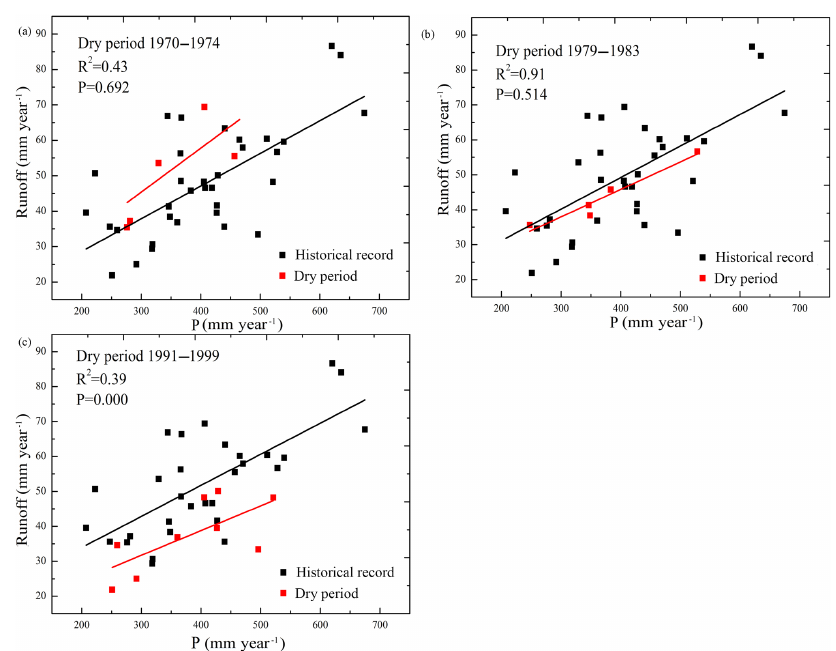
Figure 3. Precipitation–runoff relationships during drought periods: (a) and (b) show no significant changes in the precipitation–runoff relationship, whereas (c) shows a significant downward change in the precipitation–runoff relationship.